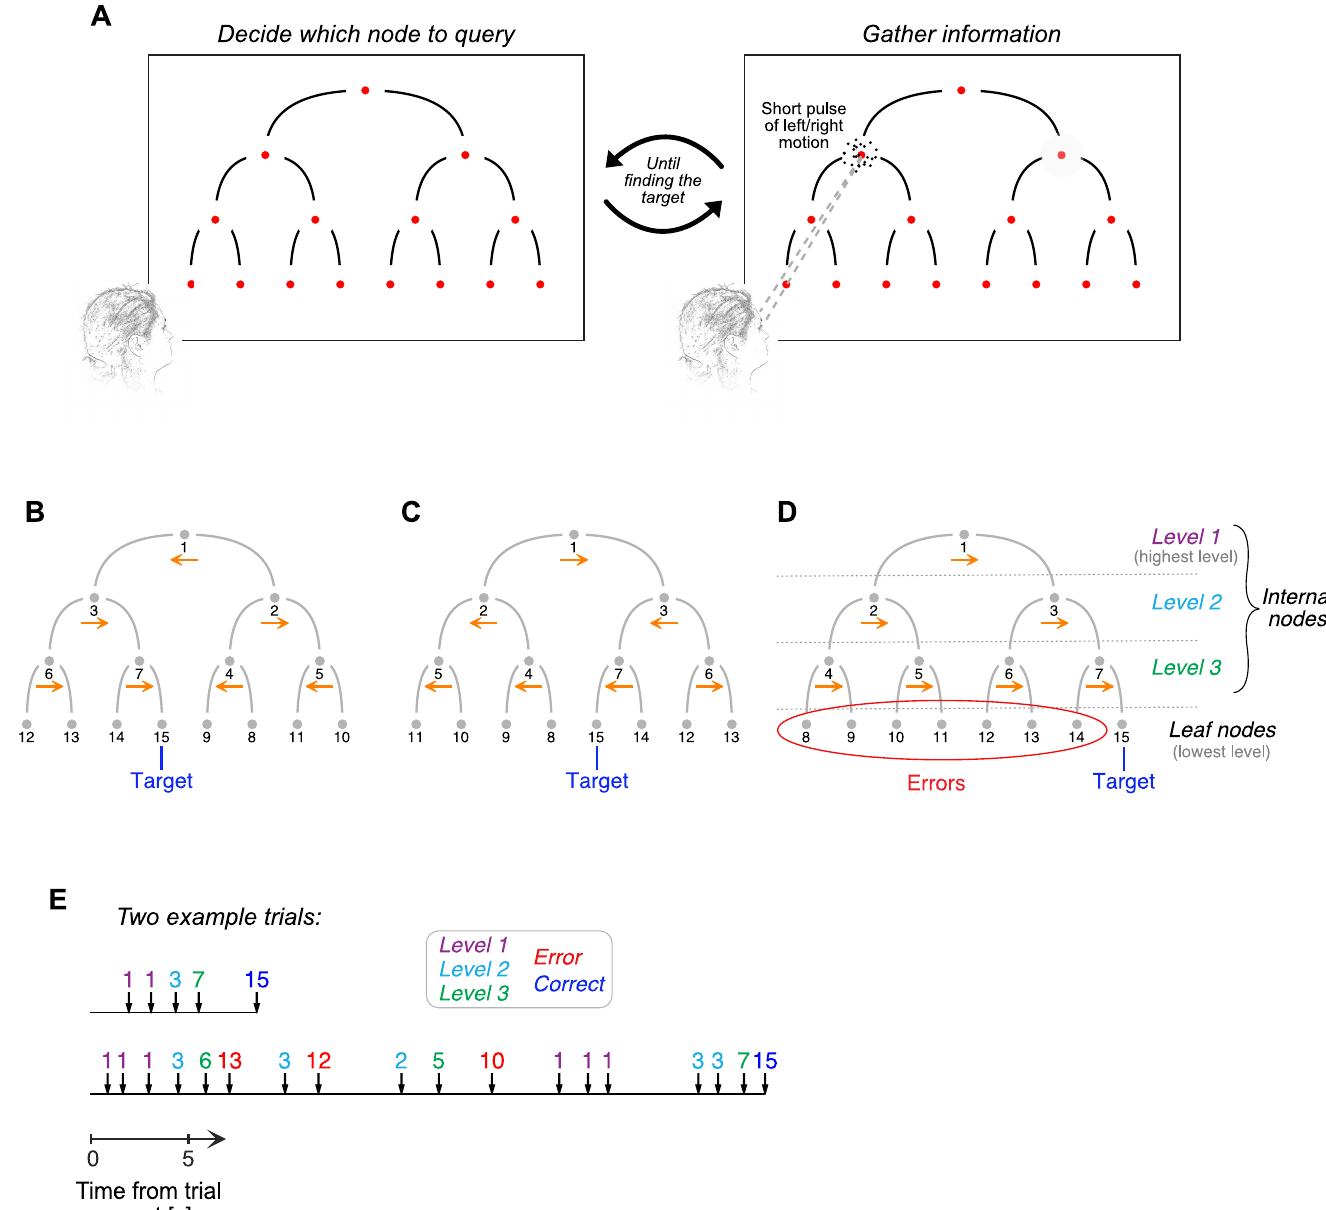
Fig 1. Hierarchical decision-making task. (A) Stimulus display. Participants had to identify which of the 8 lower-level nodes delivered a positive reward and ended the trial. Directing the gaze to a node from the top three levels of the decision tree and pressing a key triggered a short pulse of random-dot motion. The direction (left or right) and strength of motion assigned to each internal node were randomly selected in each trial. The target could be identified by following the correct direction of motion at each bifurcation from the root node to a leaf node. Participants were free to explore the decision tree as they wished to maximize the number of points earned. (B–C) Correct direction of motion at each internal node for two example trials. The true direction of motion is indicated by the horizontal arrows shown below each internal node. The numbers assigned to the nodes do not represent spatial positions but depend on the correct direction of motion at each bifurcation (as explained in the next panel). (D) Adopted nomenclature. Levels 1 to 3 are internal nodes. The leaf nodes are those at the lowest level of the decision tree. Nodes are numbered depending on the correct direction of motion at each bifurcation. If rightwards were the correct direction of motion at every bifurcation (as indicated by the horizontal arrows), the number assigned to each node would increase from top to bottom and from left to right, as indicated in the panel. (E) Example of sequence of choices from two representative trials. The vertical arrows indicate when a node of the decision tree was queried. The numbers above the arrows identify the node that was queried, following the convention described in panel